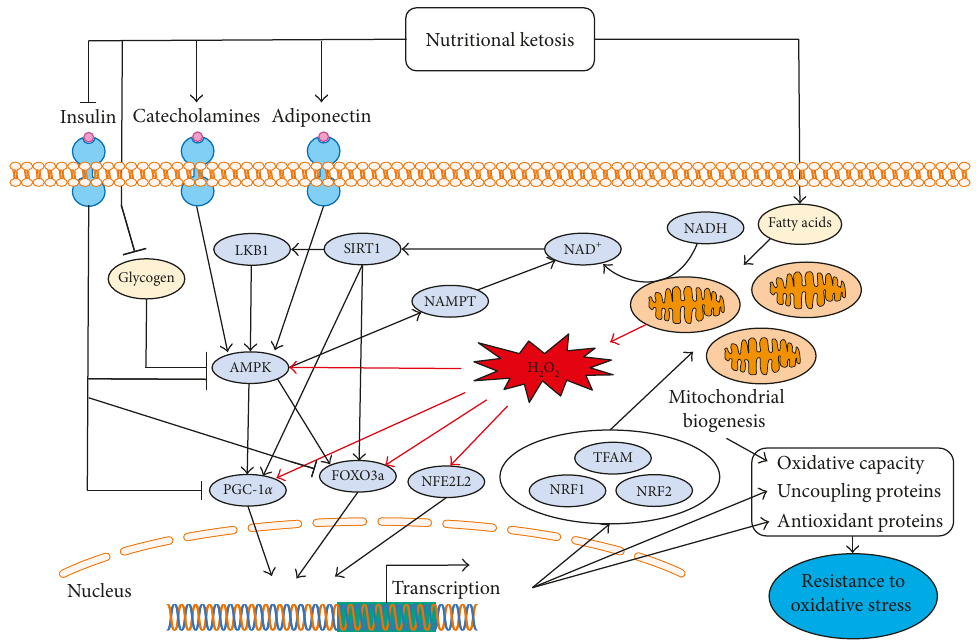
Figure 2: Nutritional ketosis may initiate bioenergetic and mitohormetic signaling through an increase in catecholamines or adiponectin, a decrease in insulin or glycogen, or an increase in β -oxidation that leads to an increase in mitochondrial reactive oxygen species (mtROS) or NAD + . This leads to further signaling involving AMP-activated protein kinase (AMPK), silent mating type information regulation 2 homologue 1 (SIRT1), peroxisome proliferator-activated receptor c coactivator 1 α (PGC-1 α ), forkhead box O 3a (FOXO3a), and nuclear factor erythroid-derived 2-like 2 (NFE2L2), ultimately leading to transcription of genes related to oxidative capacity, mitochondrial uncoupling, and antioxidant defense. These adaptations collectively contribute to resistance against oxidative stress. Other proteins involved include liver kinase B1 (LKB1), which activates AMPK; nicotinamide phosphoribosyltransferase (NAMPT), which facilitates SIRT1 ac- tivation through NAD + synthesis; and nuclear respiratory factors 1 and 2 (NRF-1 and NRF-2) and mitochondrial transcription factor A (TFAM), which promote mitochondrial